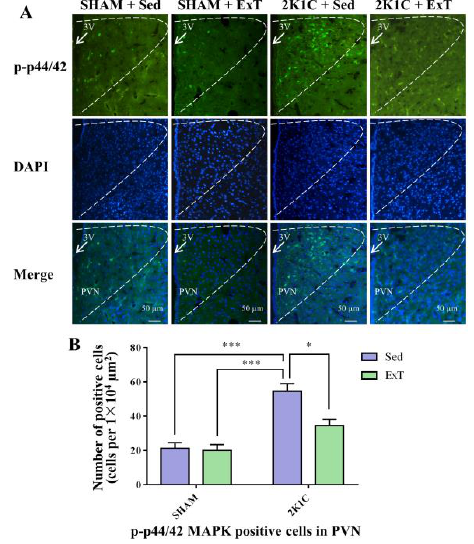
Figure 5. Eight weeks of aerobic ExT attenuated PVN level of p-p44/42 MAPK immunoreactivity in 2K1C group. ( A ) Representative immunofluorescence staining of p-p44/42 MAPK. ( B ) Densitometric analysis of immunofluorescence staining of p-p44/42 MAPK. 3V: third ventricle. * p < 0.05, *** p < 0.001, n = 4.